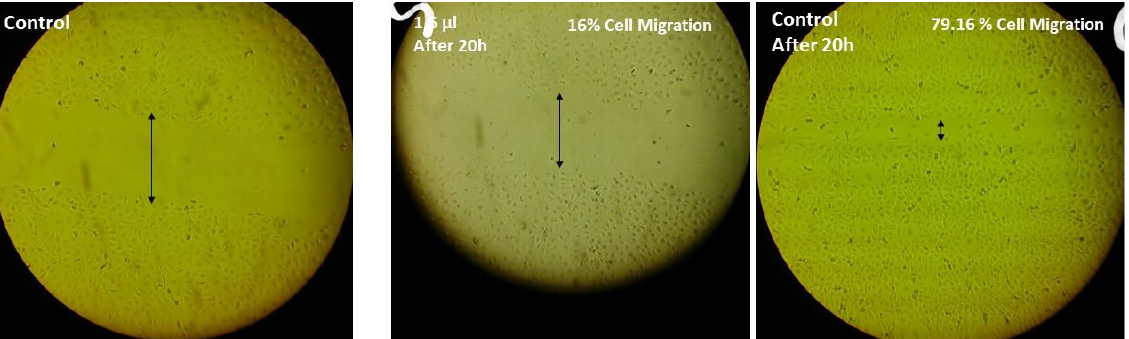
Figure 3. Migration inhibition percentage of HAE-NE in MDA-MB231 cells after 20 h of incubation. Error bar indicates the standard error of the mean of three independent experiments. Cells were visualized at 200 ×